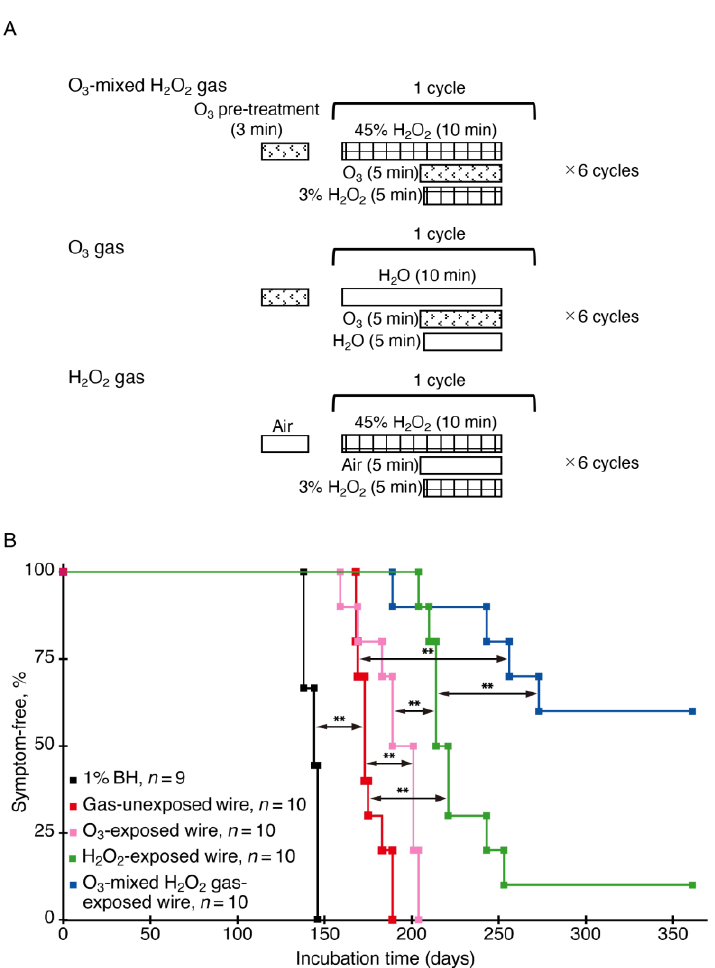
Figure 1. Ozone gas and vaporized hydrogen peroxide synergistically reduce prion infectivity of stainless steel wires. ( A ) Schematic representations of the sterilization protocols for ozone gas mixed with vaporized hydrogen peroxide, ozone gas alone, and vaporized hydrogen peroxide alone in the ET (endotoxin) mode. For sterilization with ozone gas mixed with vaporized hydrogen peroxide, RML prion-contaminated stainless steel wires were pre-treated by injection of 25,000 ppm ozone gas for 3 min and followed by 6 cycles of a 10 min sterilization process, which comprises injection of 45% hydrogen peroxide followed by injection of 25,000 ppm ozone gas and 3% hydrogen peroxide 5 min later. For the treatment with ozone gas alone or vaporized hydrogen peroxide alone, water was used instead of hydrogen peroxide or ozone gas, respectively. The sterilization process of each mode is terminated by injection of air. ( B ) The percentage of symptom-free mice after intracerebral inoculation with 1% brain homogenate (1% BH) from RML-infected, diseased mice and intracerebral implantation with gas-unexposed, ozone gas-exposed, vaporized hydrogen peroxide-exposed, and ozone gas mixed with vaporized hydrogen peroxide-exposed, RML prion-contaminated wires. O 3 , ozone; H 2 O 2 , hydrogen peroxide; ** p <